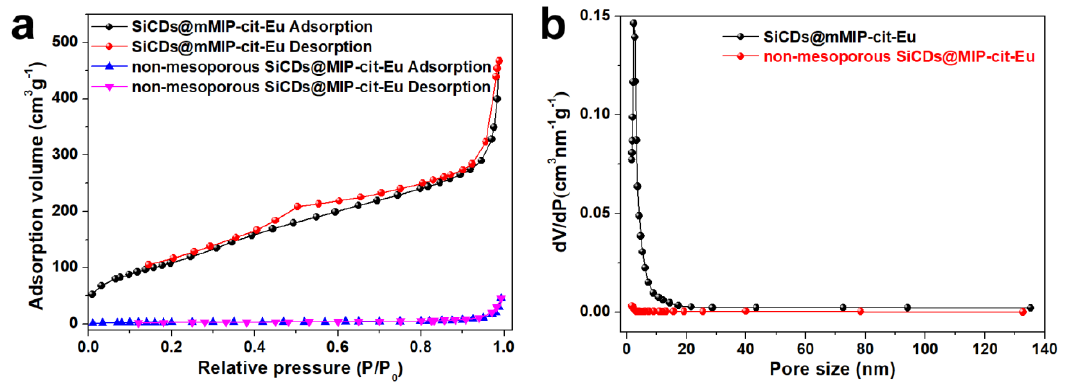
Figure 3. ( a ) The nitrogen adsorption – desorption isotherms of SiCDs@mMIP-cit-Eu and